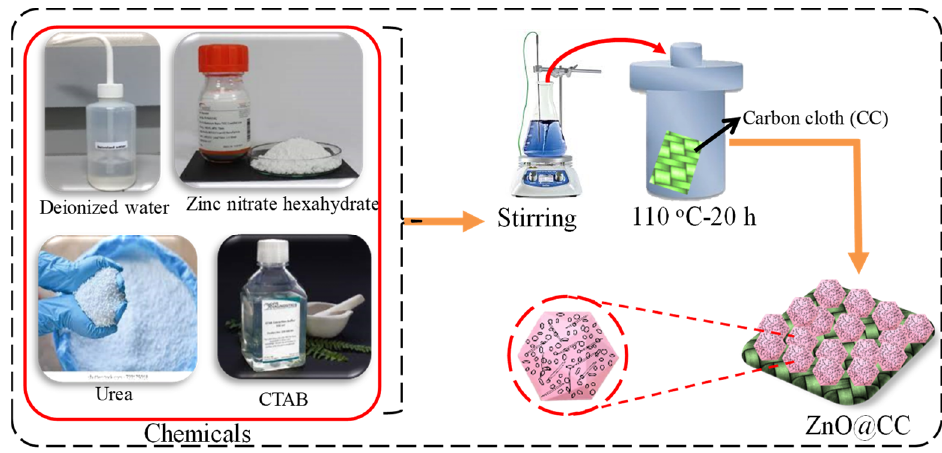
Figure 1. Schematic illustration for the synthesis process to create the ZnO@CC hexagonal cubes.